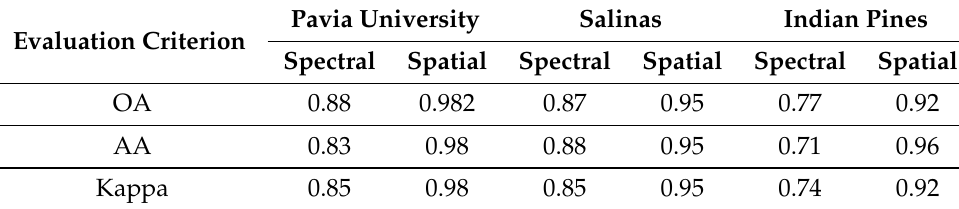
Table 3. Classification results of spectral and spatial